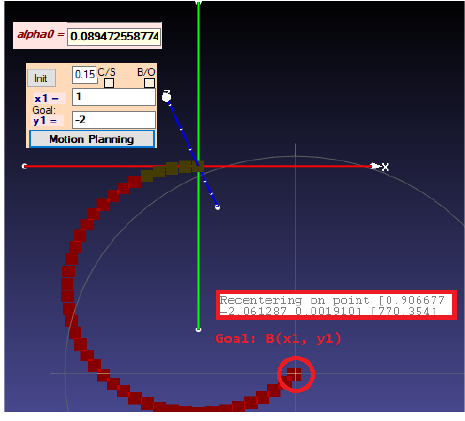
ing in the Unity 3D system.